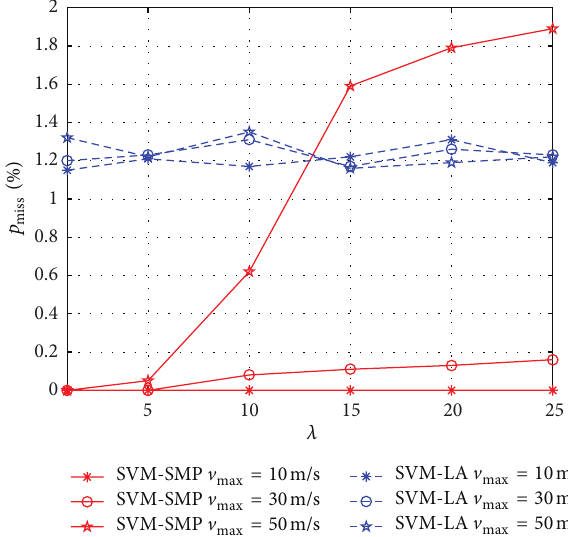
for CUs versus V max . accuracy